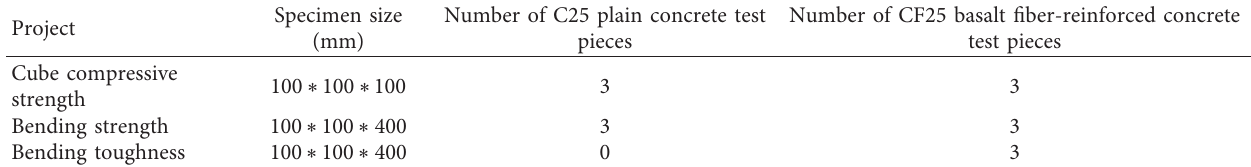
Table 1: Test contents.